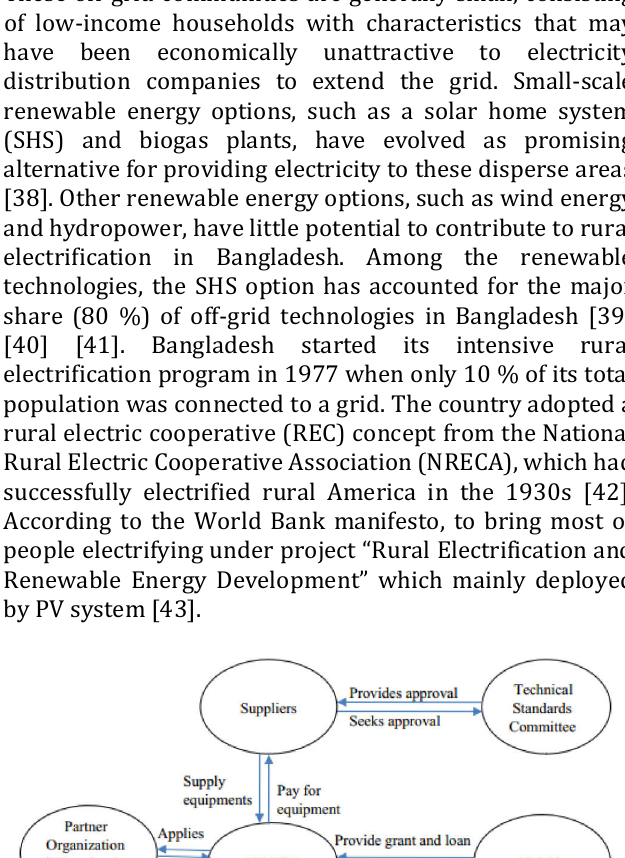
Amongst 49 partners’ organization, IDCOL has developed a competitive market for Solar PV system without any geographic constraints by offering solar incentives; SHS installation, PV system with battery and charge controller supplies across the country [44]. Achieving quality and reliability of electricity supply is an important factor for each region, enhancement of reliability factor in integrating intermittent renewable energy like solar and the wind no choice except diesel generators, issues highlighted by (Foster and Steinbuks, 2009), estimates power system that generators owned compensated by 6 % of total capacity in Sub-Saharan Africa and other low-income countries up to 20 % [45]. Renewable electrification inspiring by the institutional framework in Bangladesh present in figure 8.